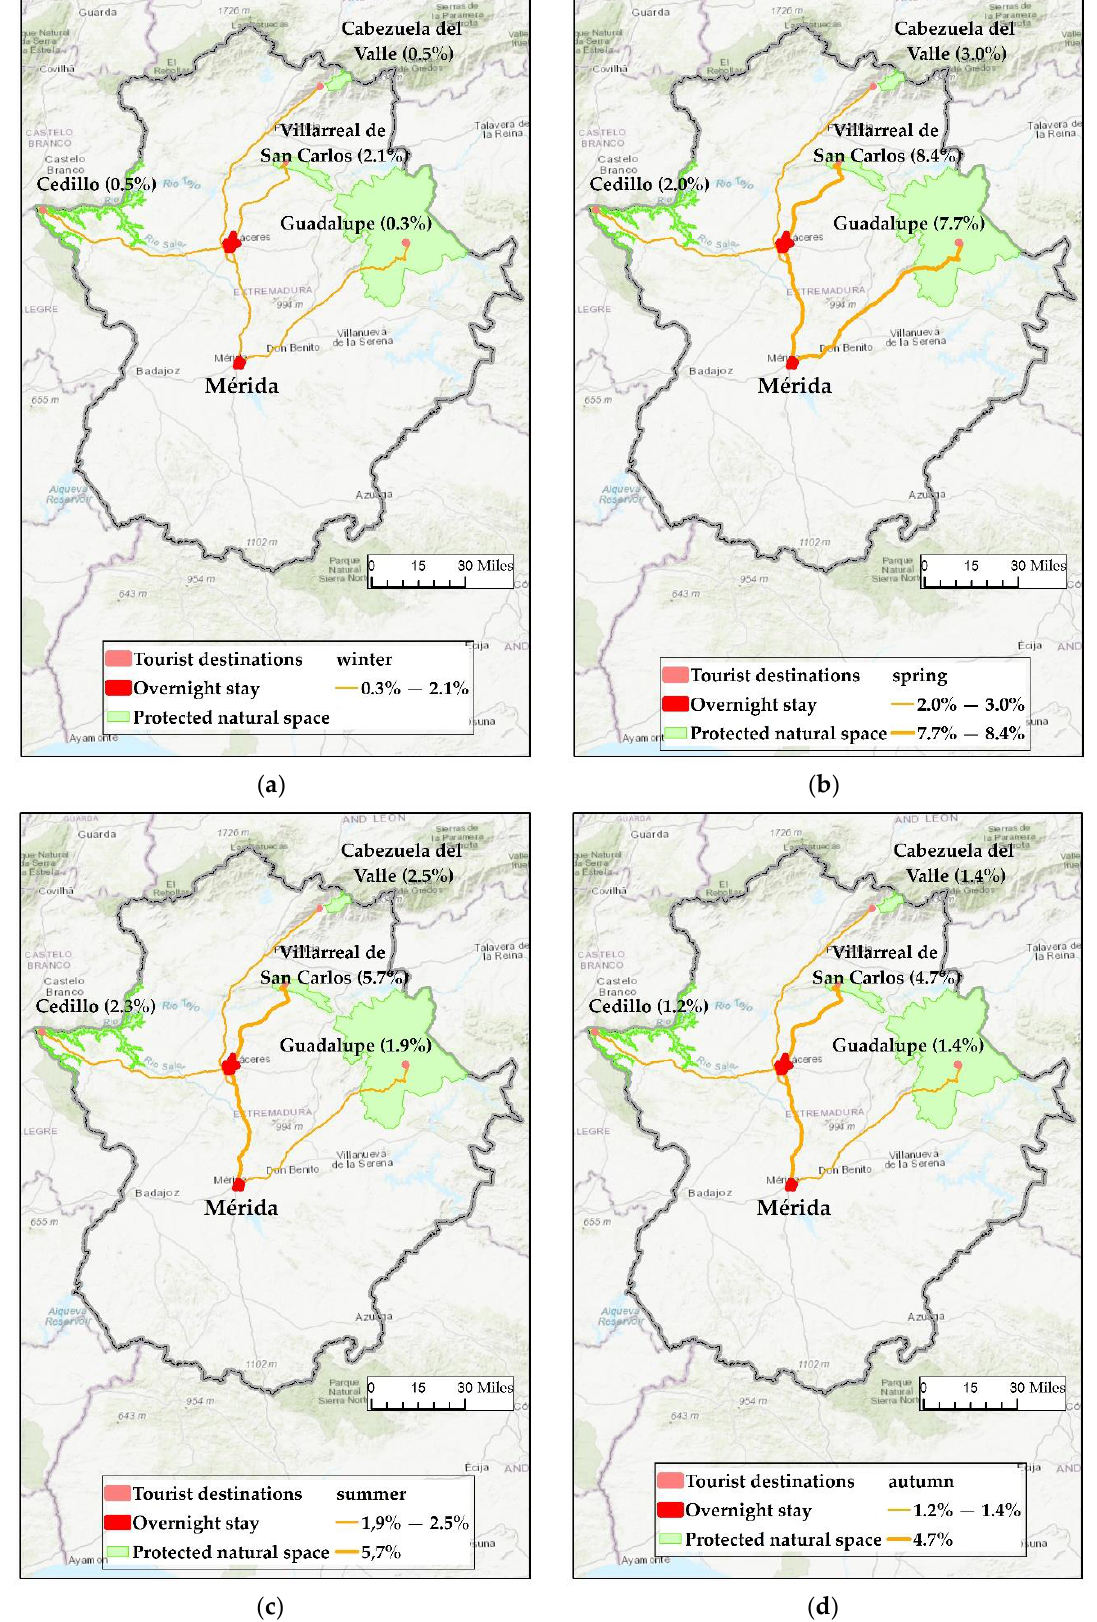
Figure 5. Journeys made by tourists staying in Mérida: ( a ) winter; ( b ) spring; ( c ) summer; ( d ) autumn.